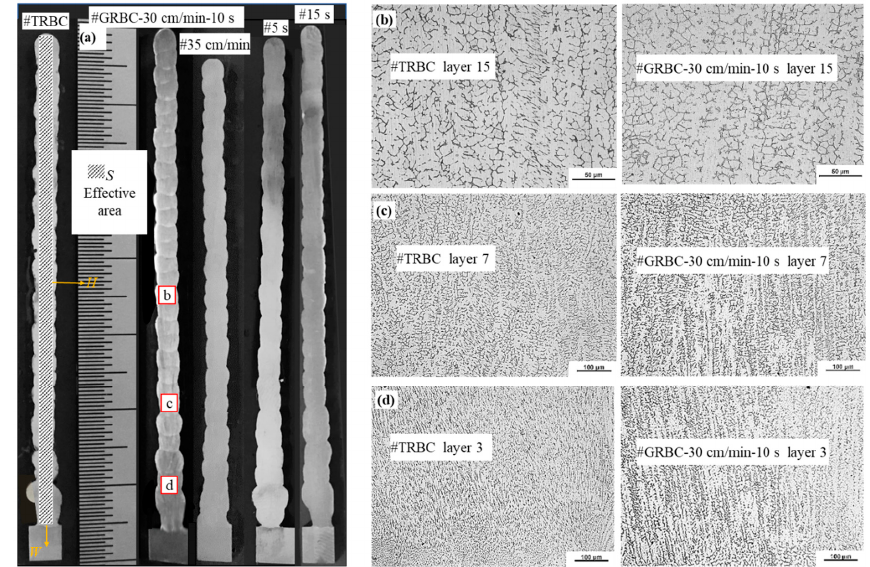
Figure 6. Macrographs and microstructures of transverse cross-sections of sample midsections: ( a ) Macrographs of transverse cross-sections of sample midsections; microstructures of samples #TRBC and #GRBC-30 cm/min-10 s, ( b ) on the 15th layer, ( c ) on the 7th layer, and ( d ) on the 3rd layer. (TRBC and GRBC represent transient and gradual reduction of bottom current,